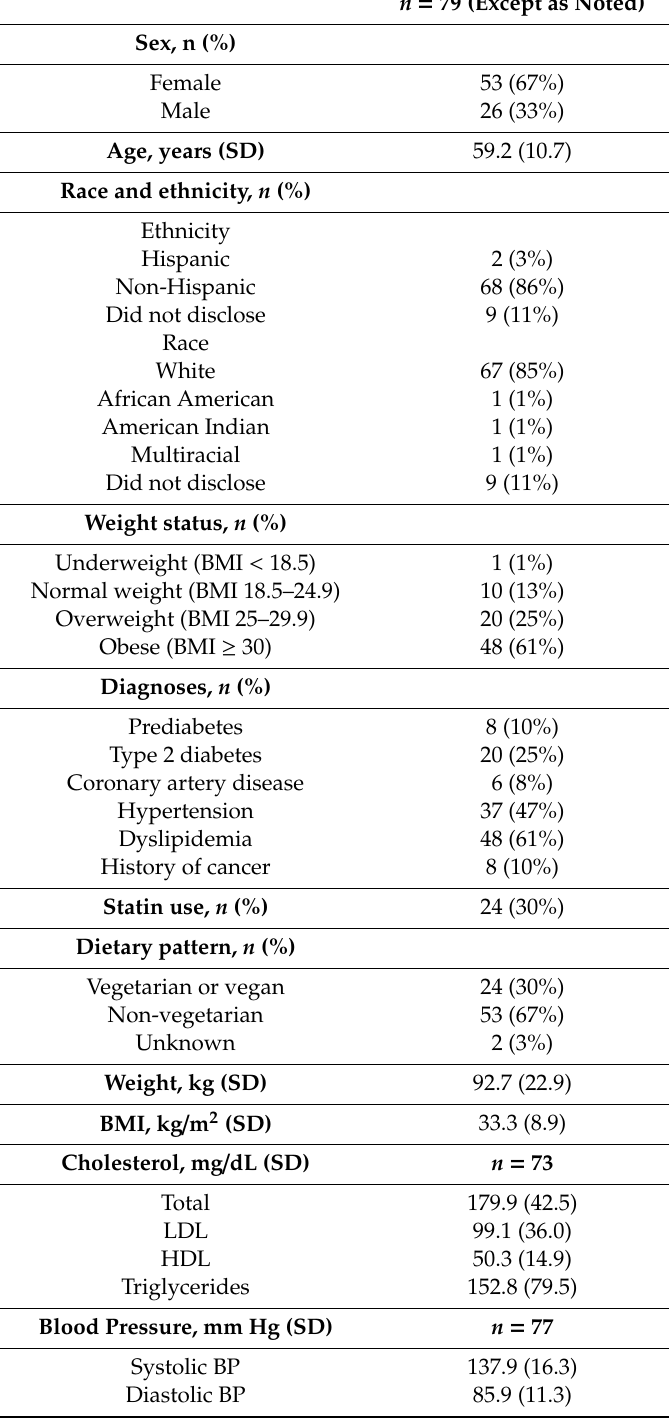
Table 2. Participant characteristics at